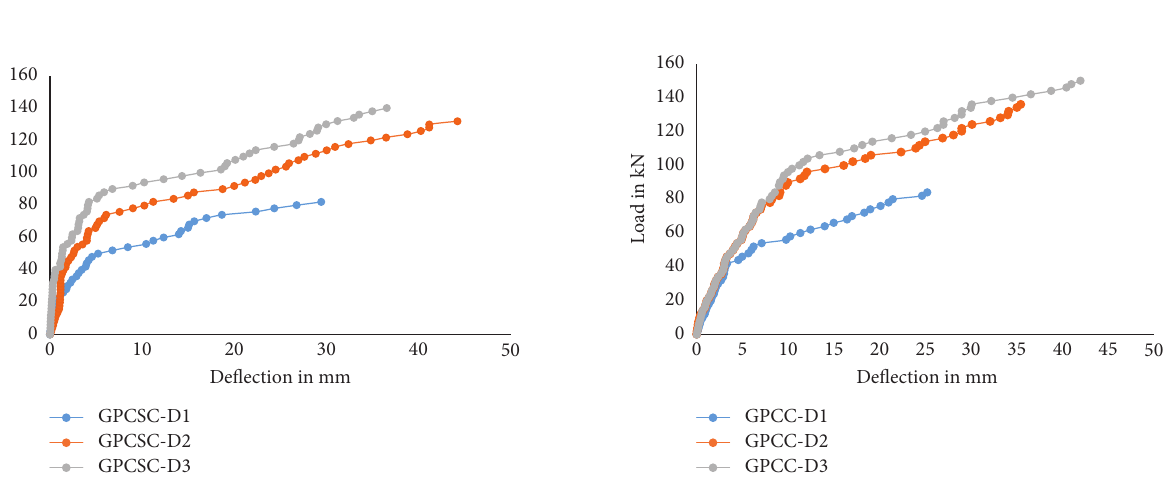
Figure 14: Load-deflection behaviour of GPCC